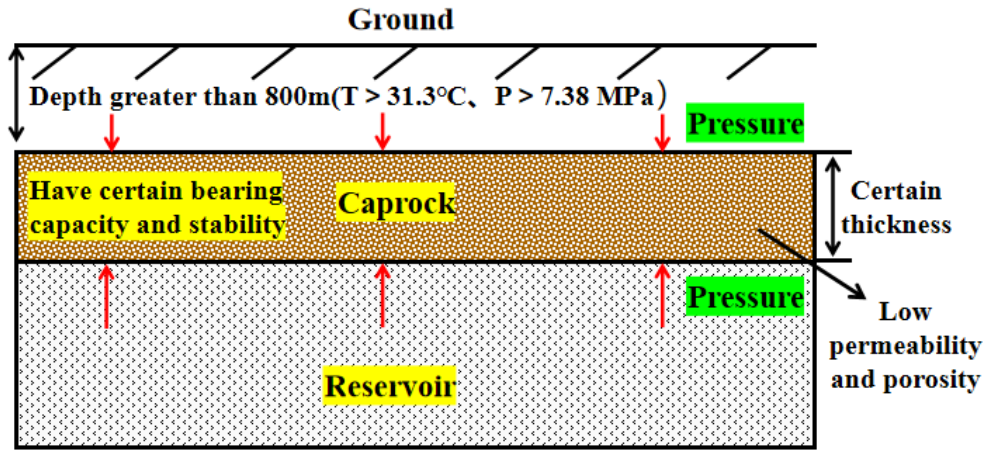
Figure 1. Certain requirements for the caprock.